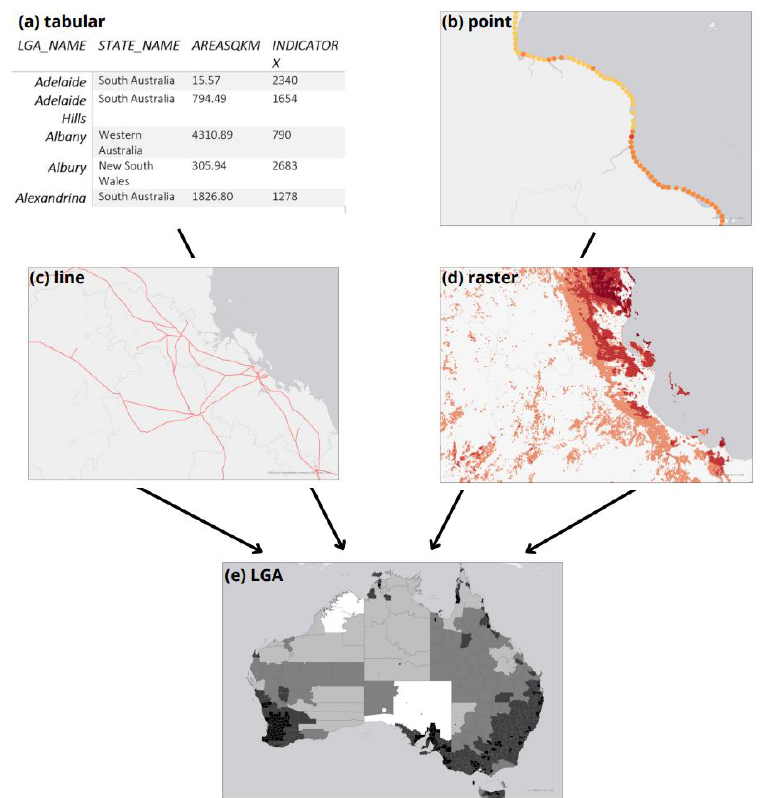
Figure 2. Diagram representing data formats of acquired raw data (tabular ( a ), point ( b ), line ( c ), and raster ( d )) being transformed into a comparable LGA polygon format ( e ). Example data are used here, and ( d ) is not representative of any